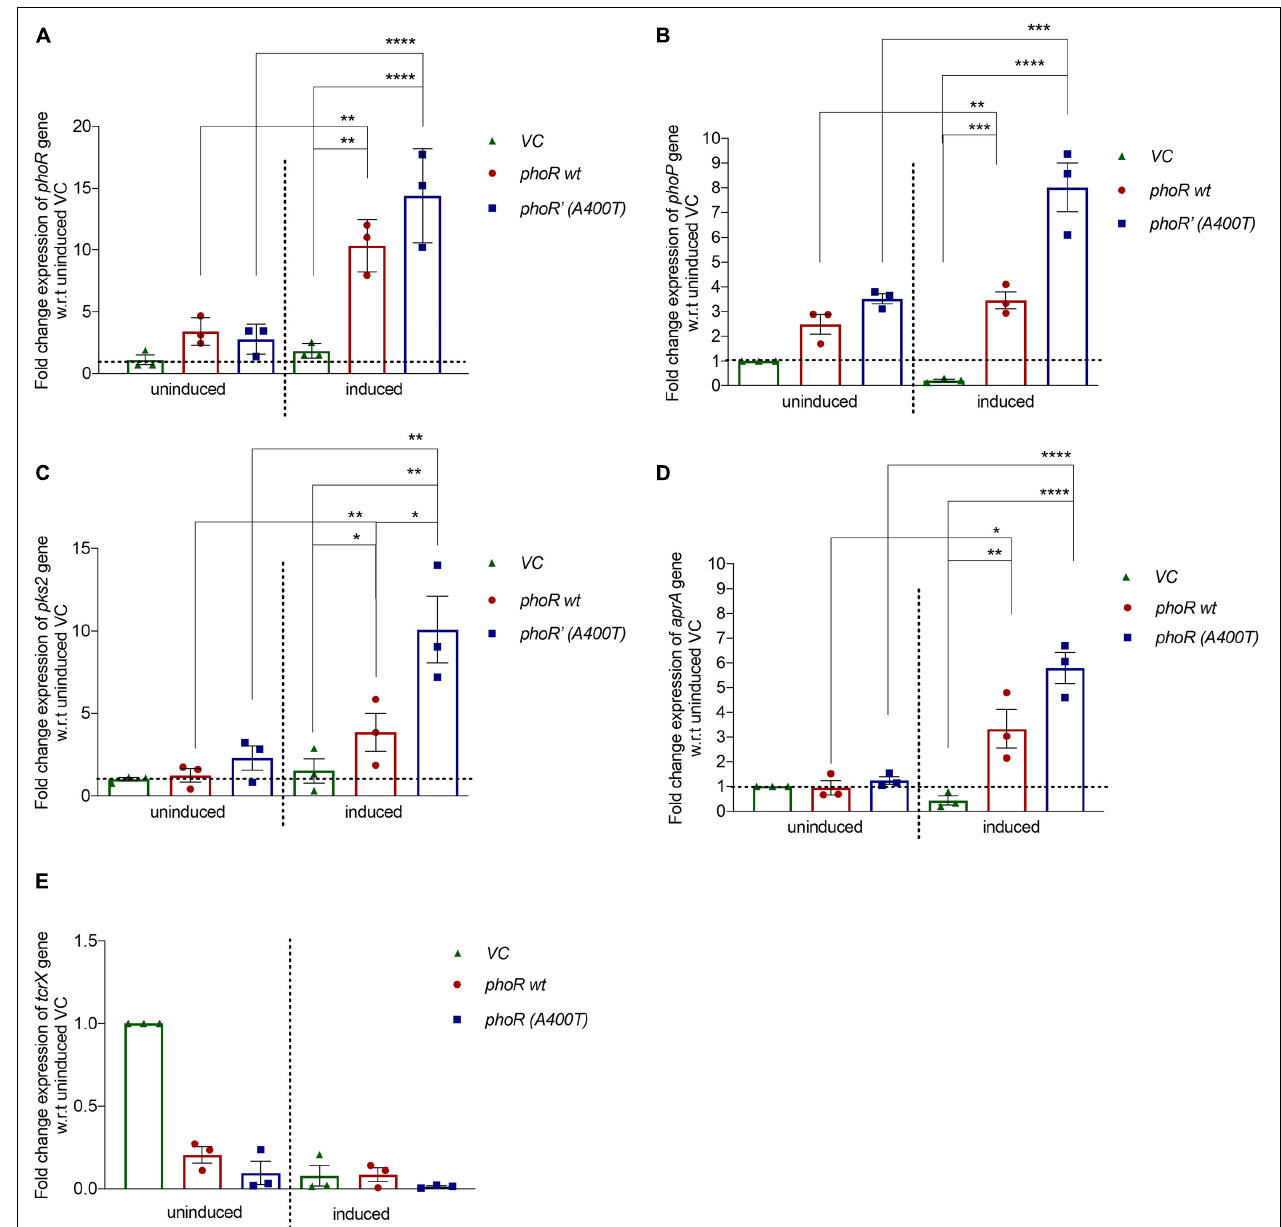
FIGURE 4 | Expression analysis of downstream genes in Mycobacterium tuberculosis H37Ra strain complemented with wild-type or mutant phoPR operon. Relative mRNA expression analysis from H37Ra strains carrying a single integrated copy of either vector alone (pCV125) or with the wild-type or mutant phoPR operon, grown in Middlebrook 7H9 medium at pH 7.2 (uninduced) or at pH 5.5 (acid-induced). The expression was normalized to the levels of 16S rRNA, followed by the levels of the specific gene in the uninduced condition in strains carrying the empty vector (vector control). For all panels: left, uninduced (pH 7.2); and right, induced (pH 5.5). Expression analysis for (A) phoR gene, (B) phoP gene, (C) pks2 gene, (D) aprA gene, and (E) tcrX is shown. The primer sequences for all the genes examined were obtained from previously published studies and listed in Supplementary Table 1 . For all experiments, n = 3, where n represents the number of biological replicates. p -values, * ≤ 0.05, ** ≤ 0.01, *** ≤ 0.001, and **** ≤ 0.0001, were determined by one-way